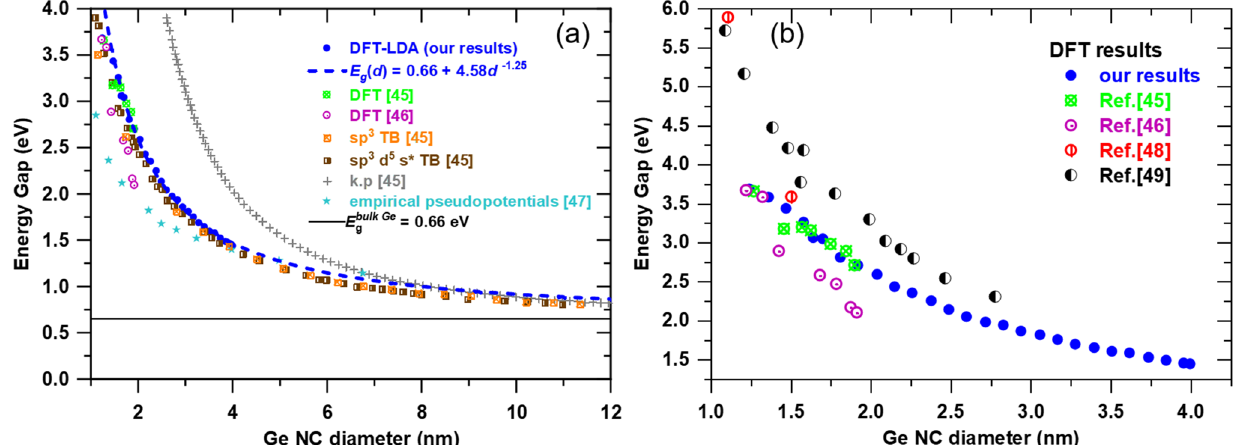
Figure 5. Energy gap dependence on diameter obtained in the frame of different calculations: ( a ) our DFT results (blue filled circles for calculated points and dashed line for the power law dependence in Eq. 1) compared to reported results obtained by DFT 45,46 , TB 45 , k · p 45 and empirical pseudopotentials 47 ; ( b ) our DFT data compared to others 45,46,48,49